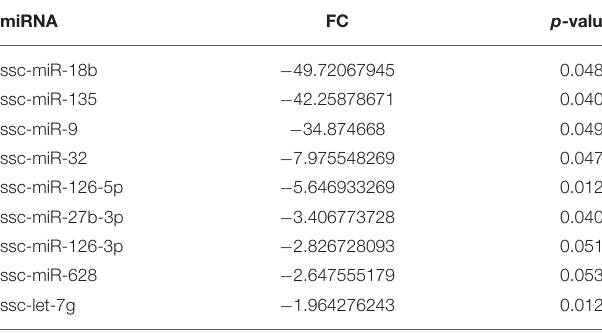
Negative fold change (FC) indicates the miRNA is downregulated in MF fed piglets compared to HM fed piglets while positive FC indicates miRNA are upregulated in MF relative to HM group. The data represents 9 MF and 10